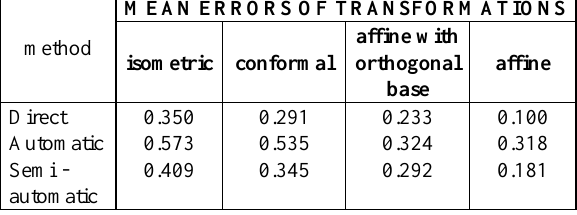
Table 1. The mean errors of the transformation for SYNAG structure